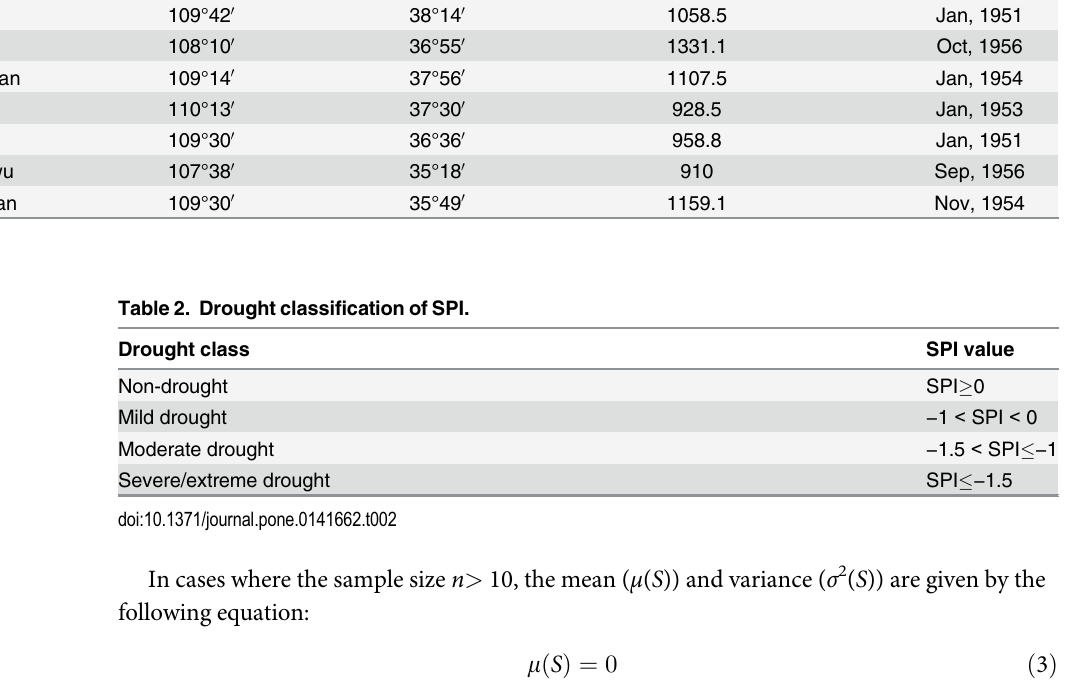
Table 1. Geographical Descriptions of the Synoptic Stations Used in the Study. Station No.